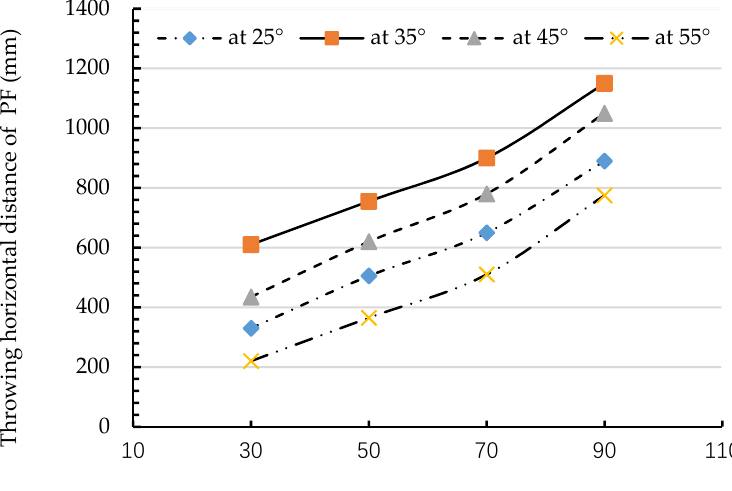
Figure 6. Effect of the conveying device’s rotational speed (rpm) on the throwing horizontal distance of PF (mm) at different inclination angles between conveying device and the horizontal plane (°). Rotating speed of conveying mechanism